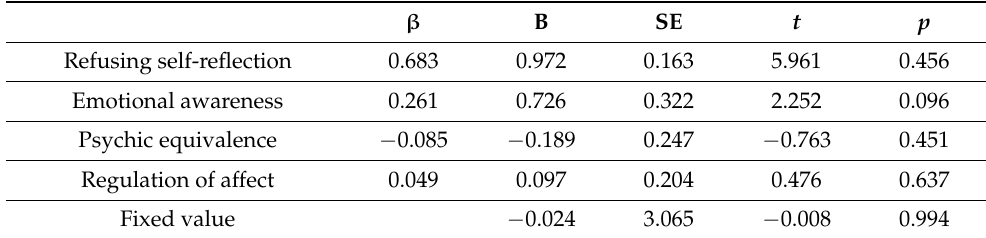
Table 11. Predictors of helplessness–hopelessness.